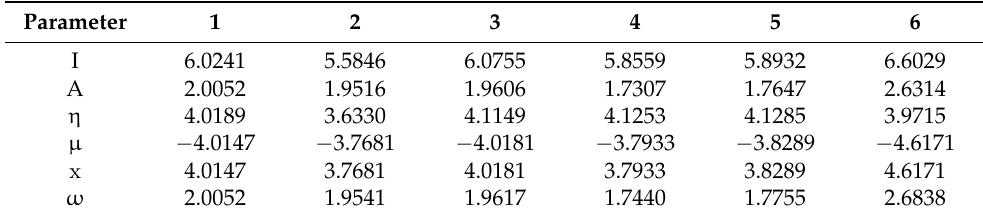
Table 6. Reactivity descriptors for the studied